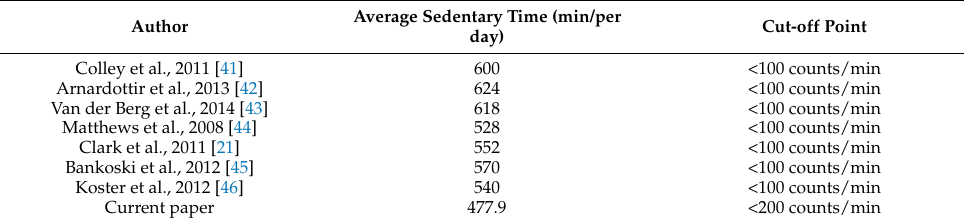
Table 7. Objectively Measured Sedentary Behaviour by